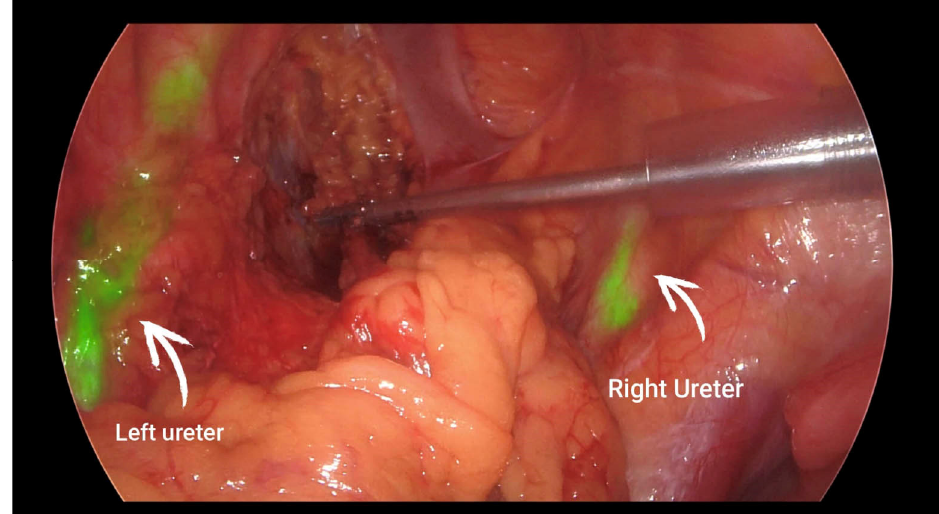
Figure 3. Ureter identification during pelvic dissection. Steven D. Wexner personal archive.